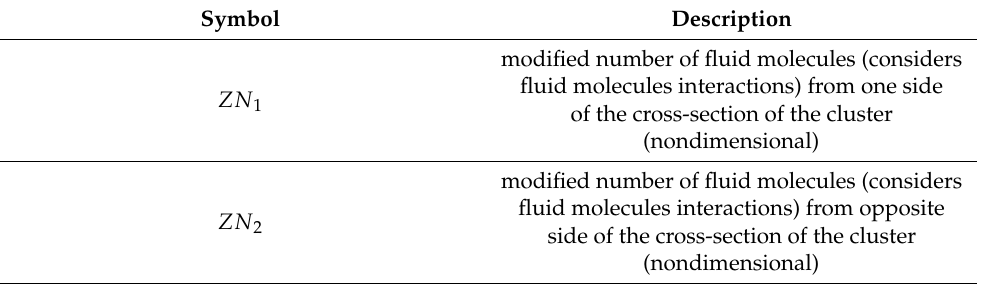
Table A2. Nomenclature used in this